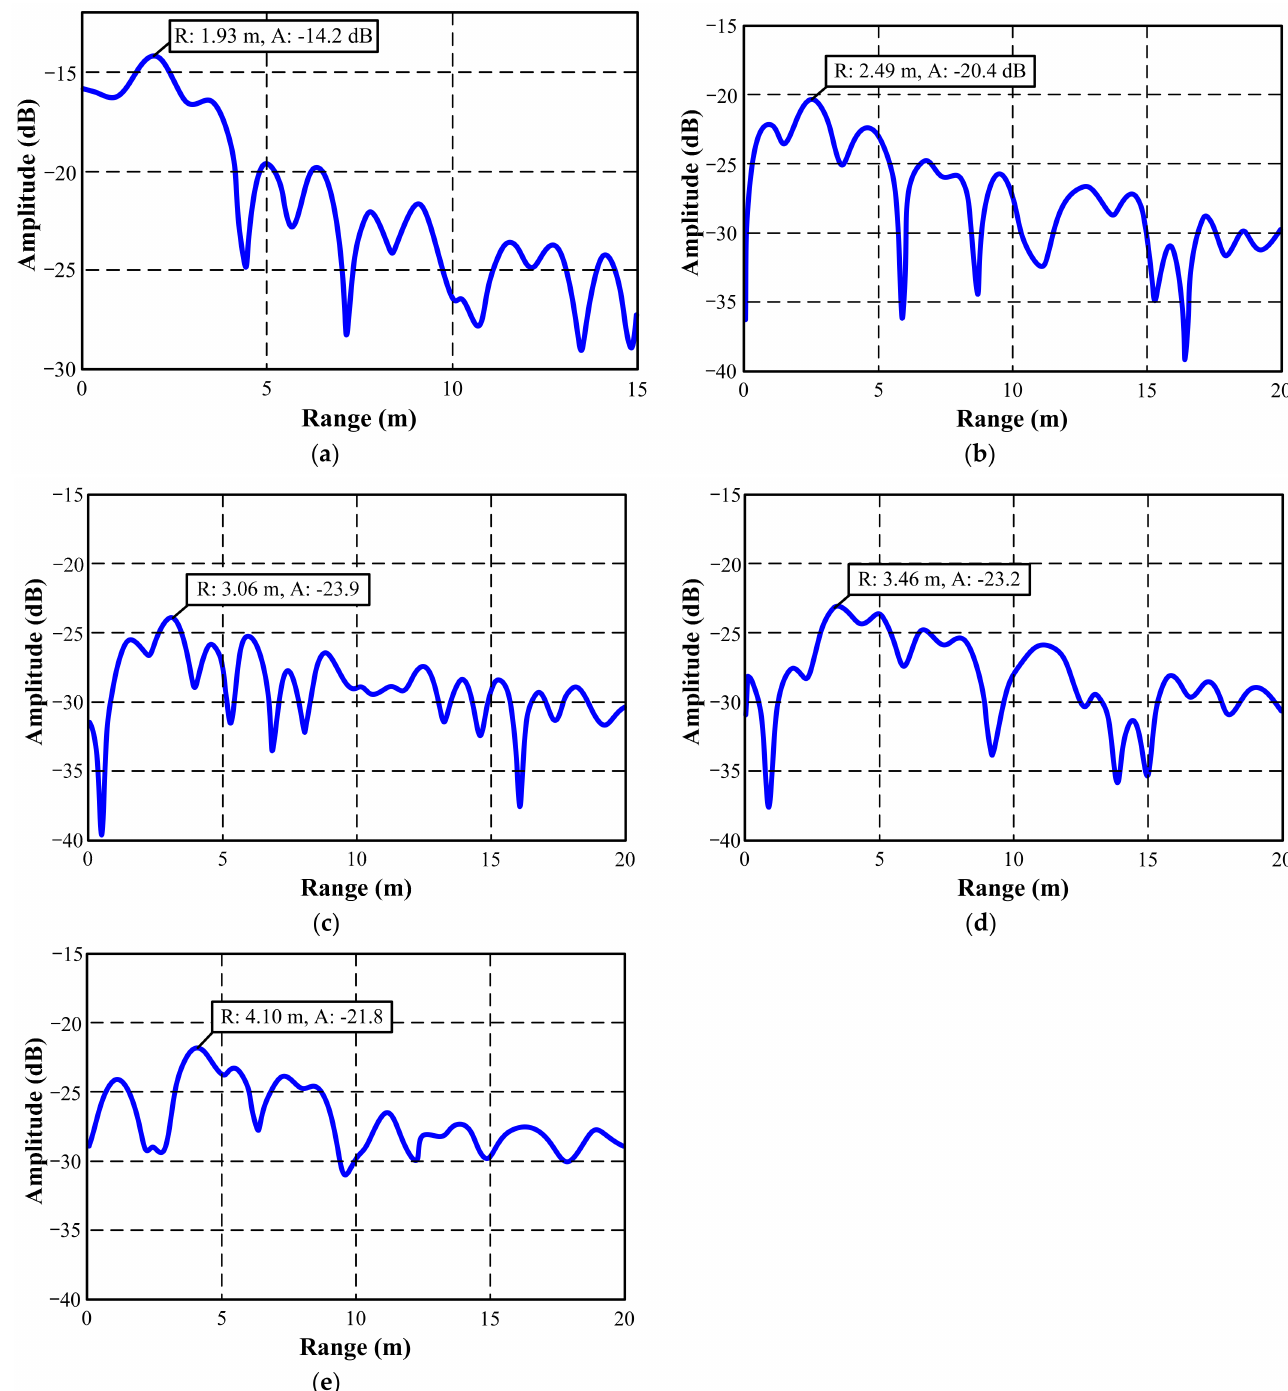
Figure 10. Through-wall object-detection results: ( a ) R = 2 m, ( b ) 2.5 m, ( c ) 3 m, ( d ) 3.5 m, and ( e ) 4